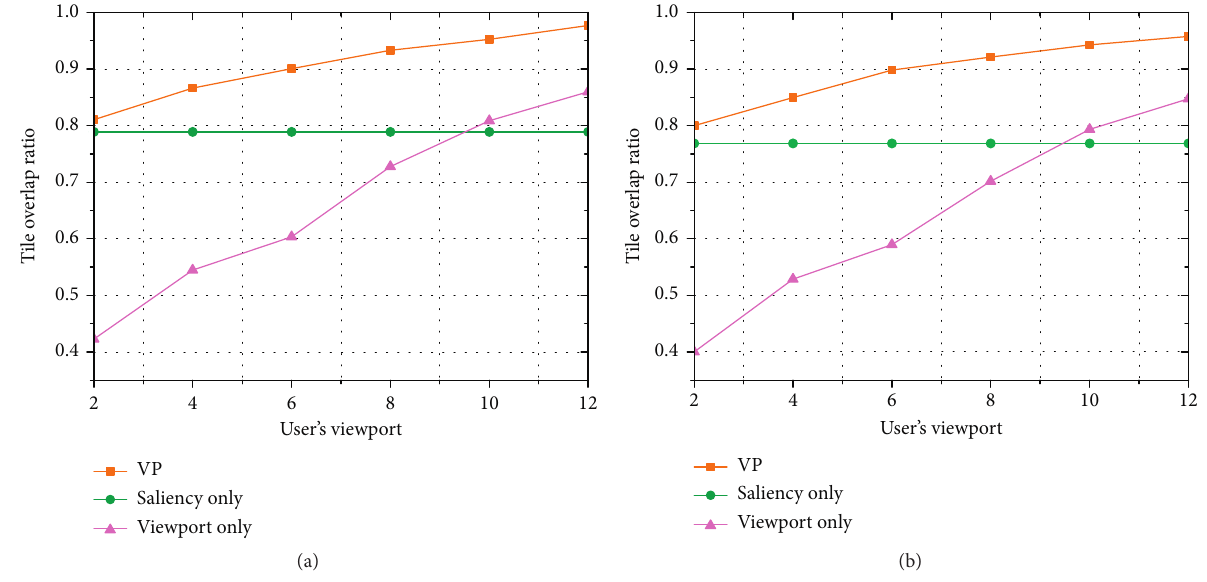
Figure 8: Tile overlapping ratio for different feedback user viewports. (a) Interval time τ